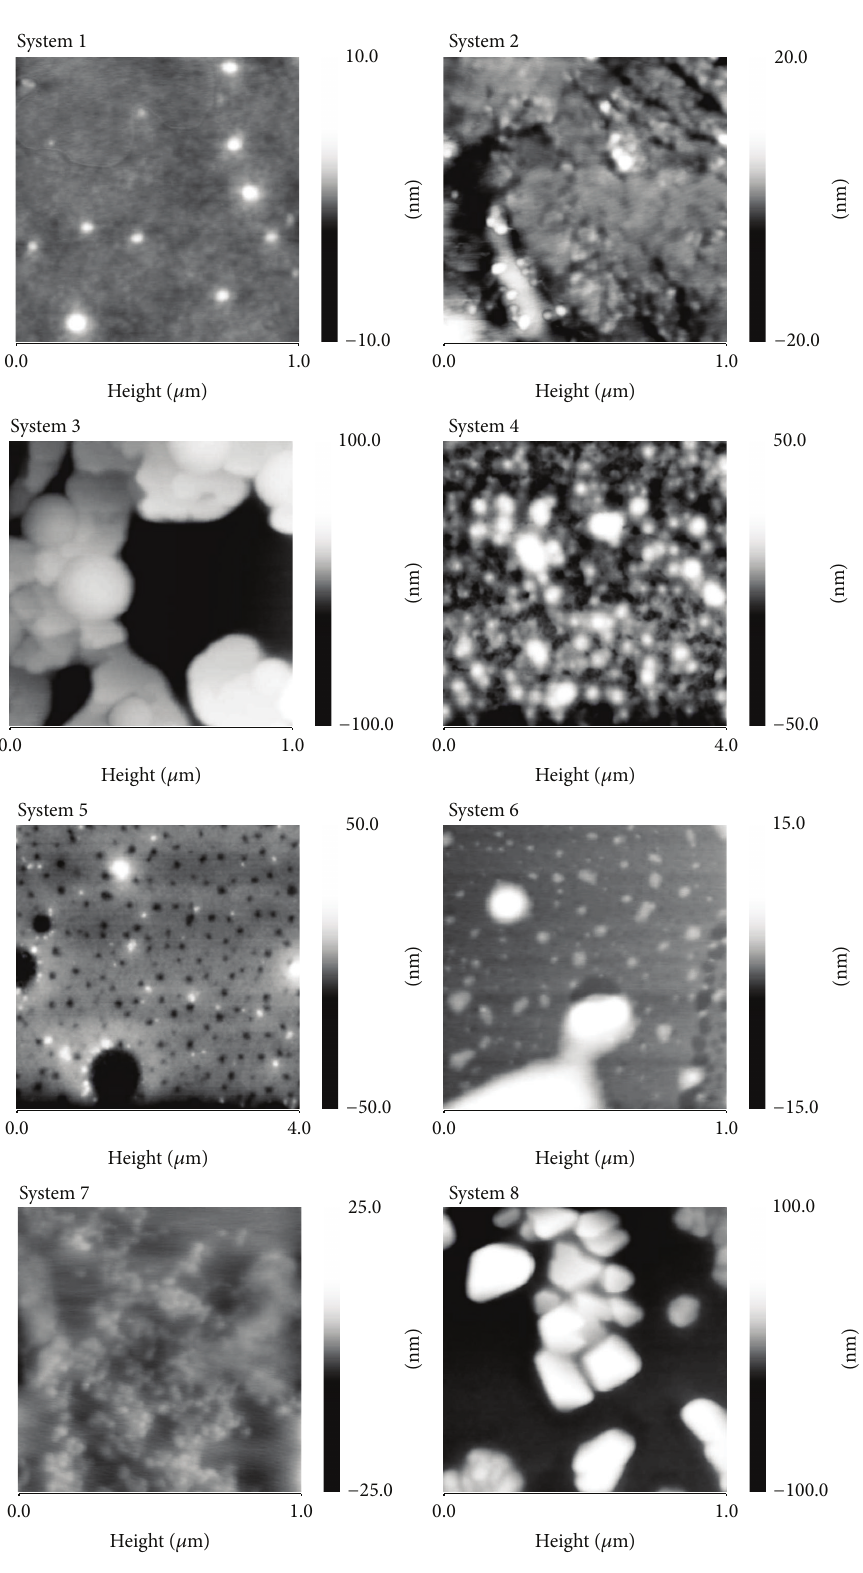
Figure 2: AFM photographs of the silver